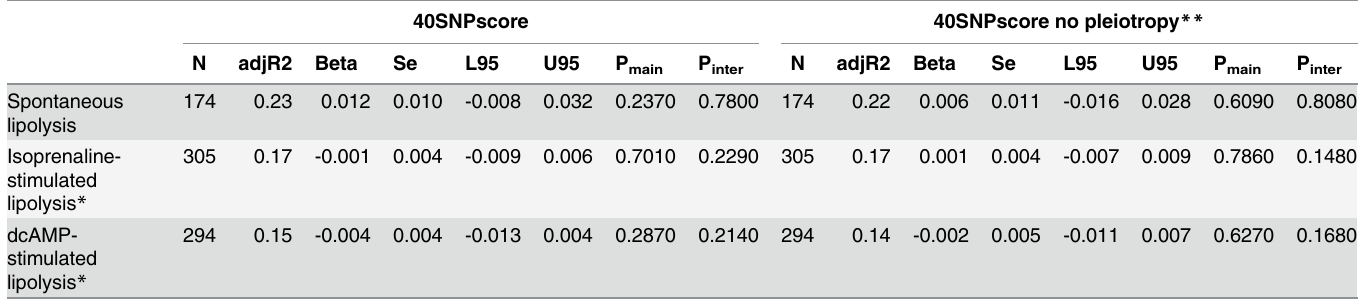
Table 4. Linear regression analysis of the effect of the WHRadjBMI-increasing SNPscore on lipolysis